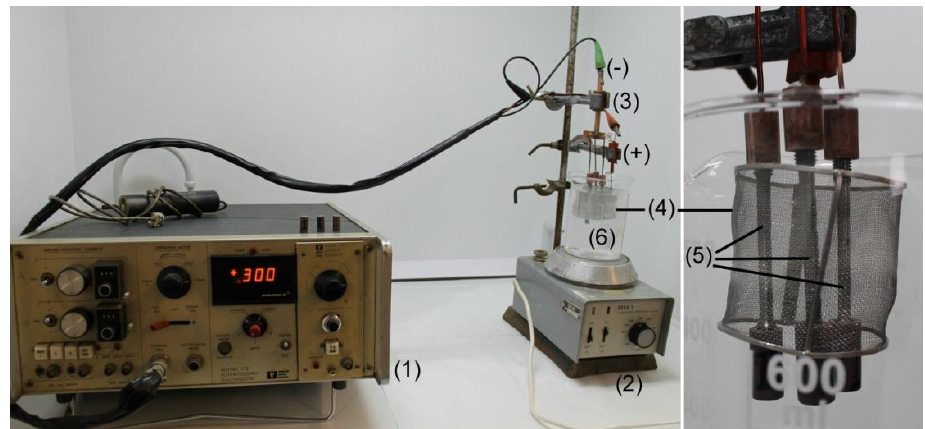
Figure 2. Experimental apparatus for electrochemical hydrogen charging: (1) potentiostat, (2) solute mixer, (3) samples holder, (4) platinum mesh electrode, (5) tensile samples, (6) electrolytic solution.